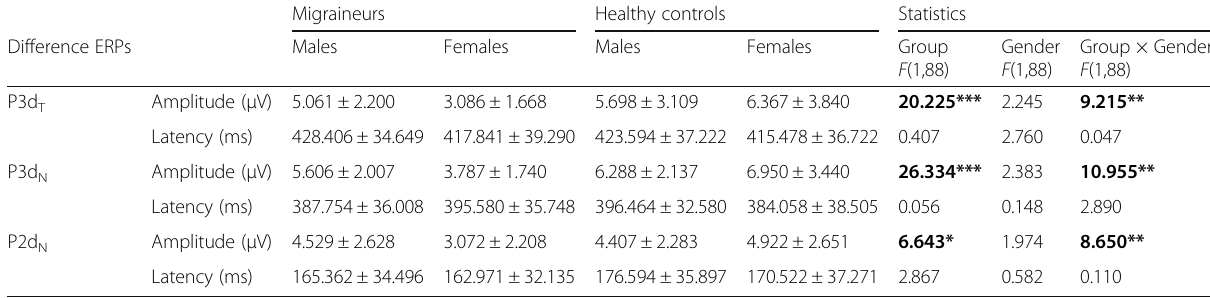
Table 4 Results and analyses of difference ERP components Migraineurs Healthy controls Statistics Difference